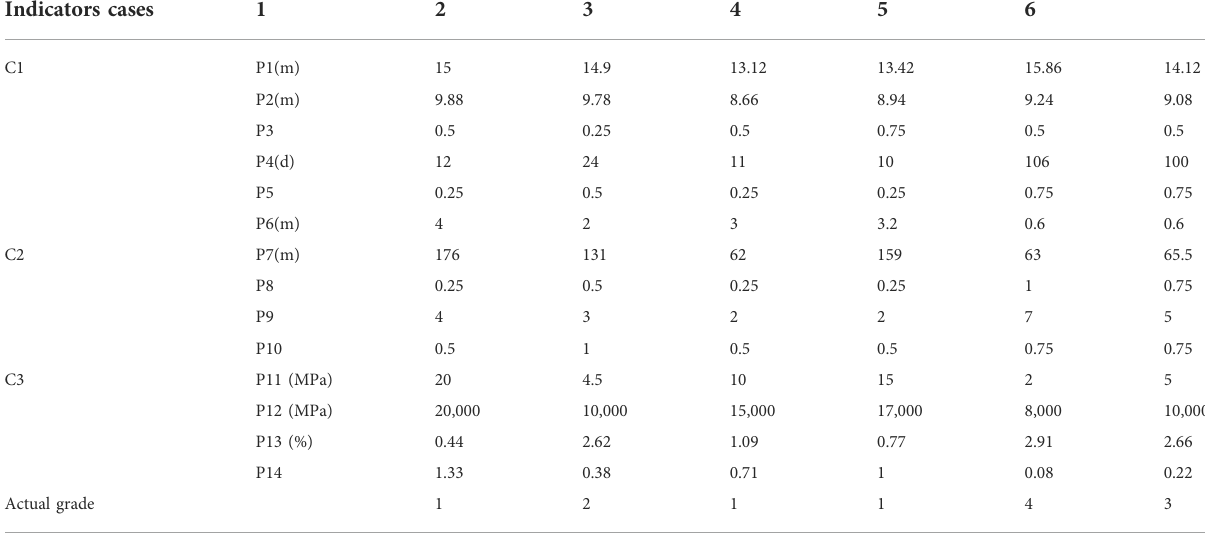
TABLE 1 Engineering cases used for tunnel squeezing evaluation.